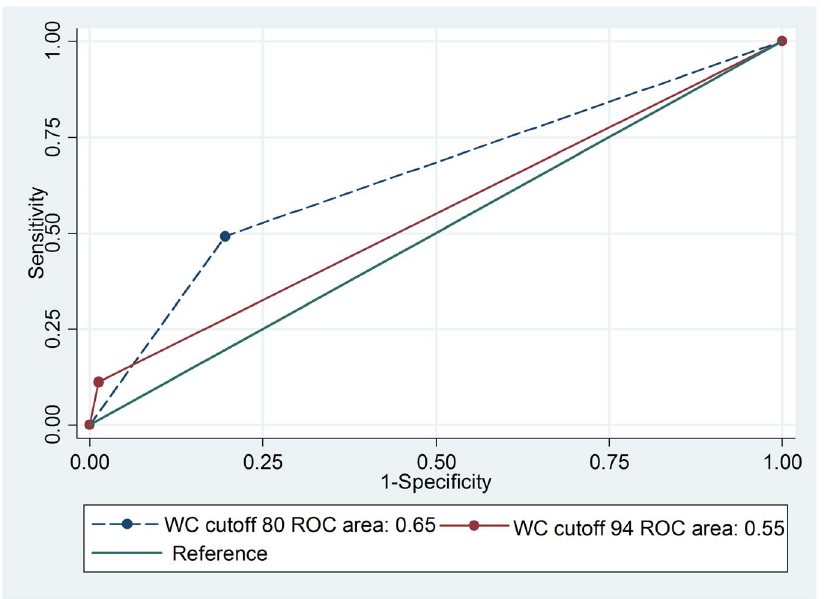
Figure 3. ROC curve comparing two WC categories for predicting hypertension, diabetes mellitus and hypercholesterolemia in